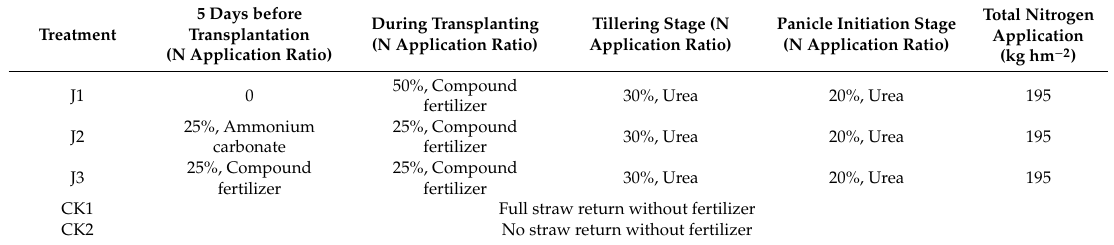
Table 1. Information about the N management used in the